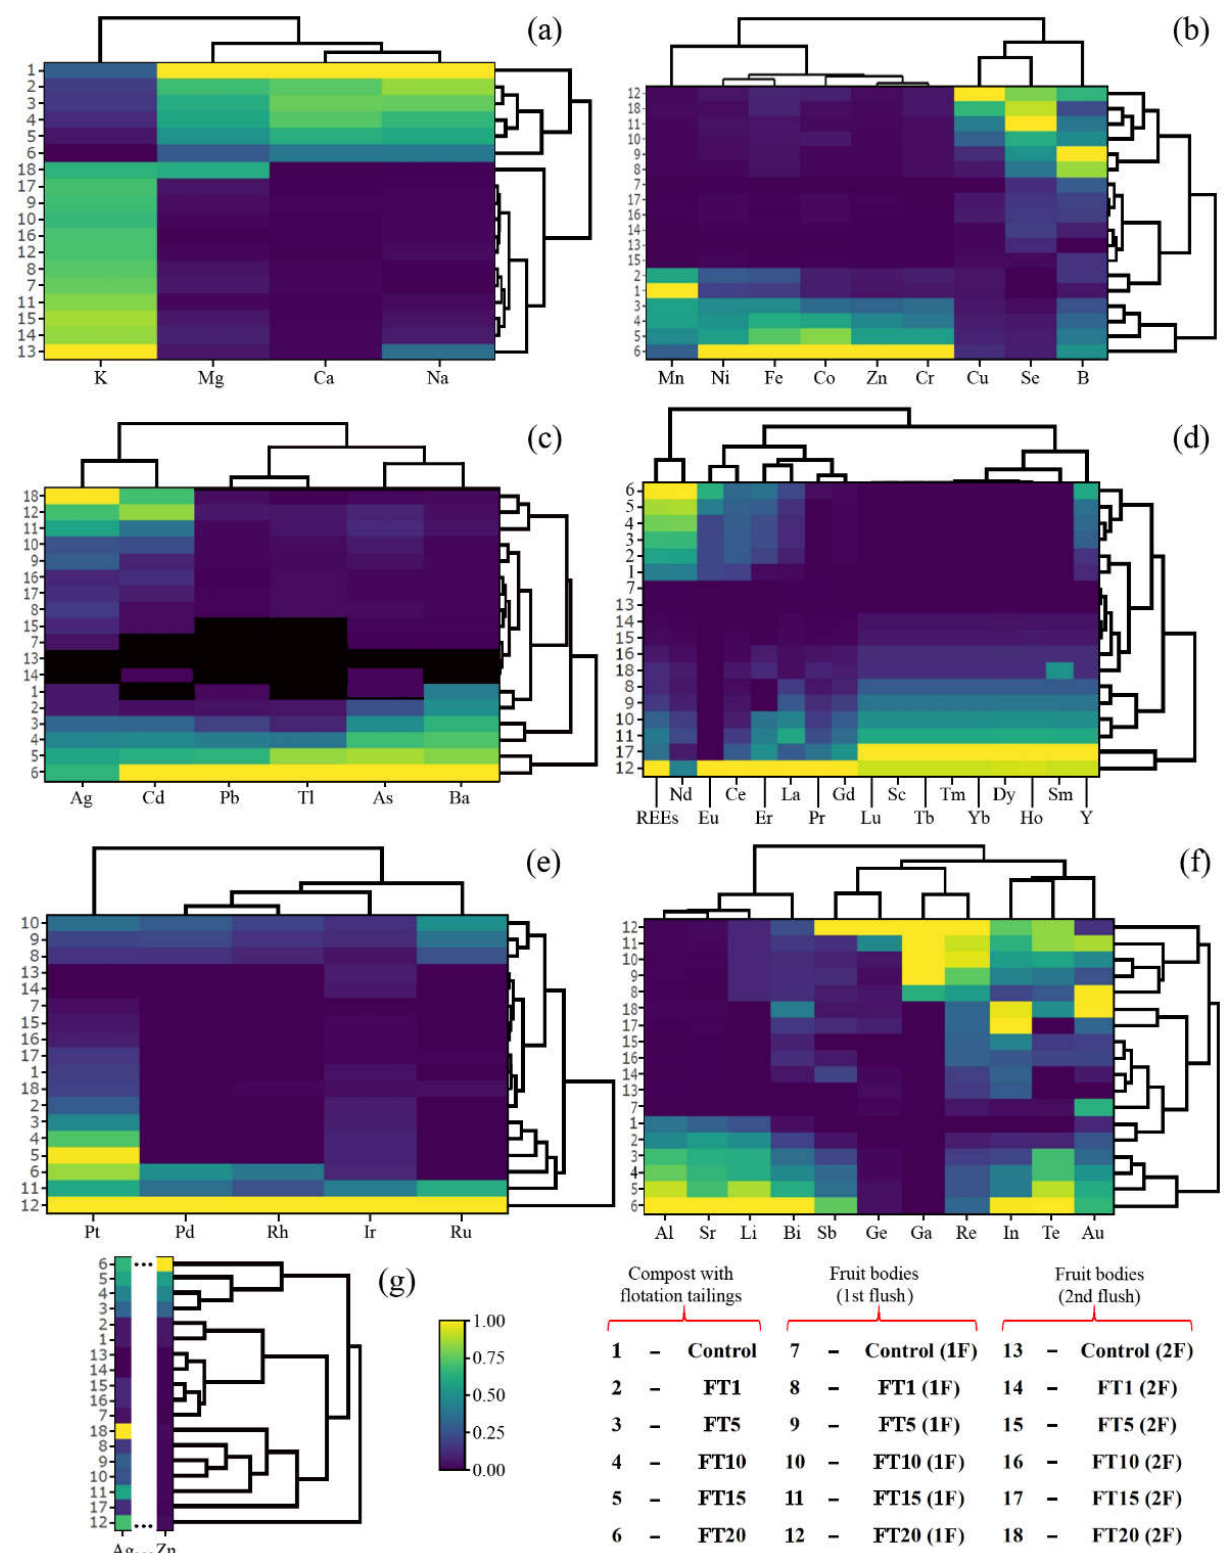
Figure 4. Correlation for compost with flotation tailings (1–6) and Agaricus bisporus collected from the 1st (7–12) and the 2nd flush (13–18) concerning the content of MEEs ( a ), ETEs ( b ), TEWDHE ( c ), REEs ( d ), PGEs ( e ), NNEs ( f ), and all elements jointly ( g ) .